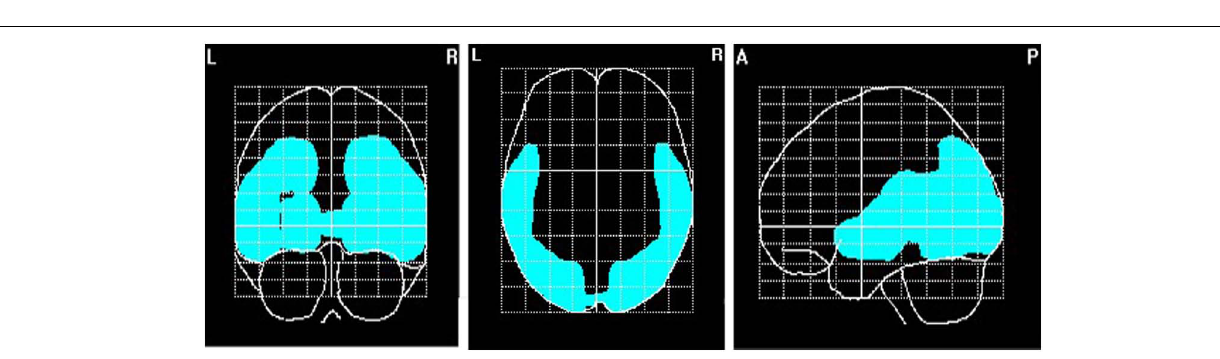
FIGURE 5 |Topographical distribution of ln alpha power for participants with (A) low affiliation motive (below percentile 25) and (B) high affiliation motive (above percentile 75).